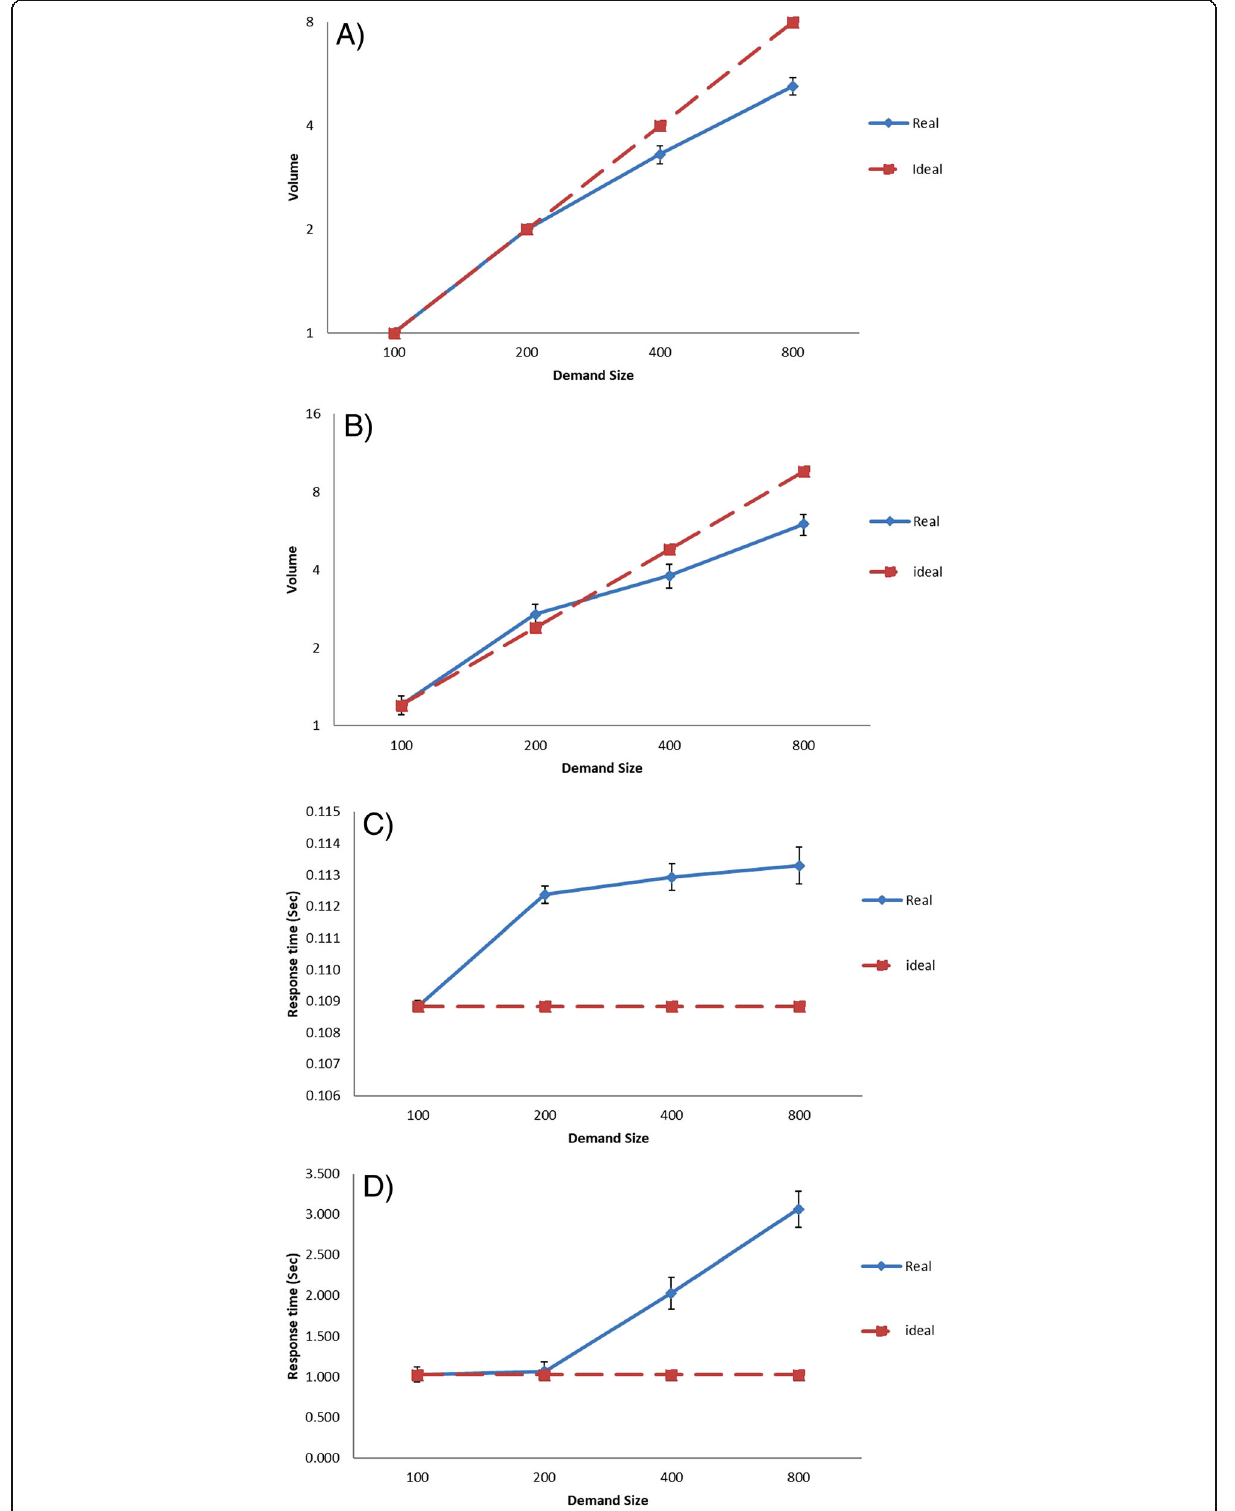
Fig. 8 The average response times and number of software instances for MediaWiki in EC2. a , b Average number of software instances- Steady rise and fall of demand scenario, Series of step-wise increases and decreases of demand scenario respectively. c , d Average response times – Steady rise and fall of demand scenario, Series of step-wise increases and decreases of demand scenario